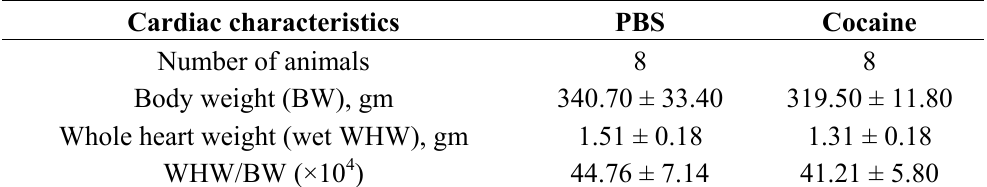
Table 1. Cardiac characteristics of PBS and Cocaine